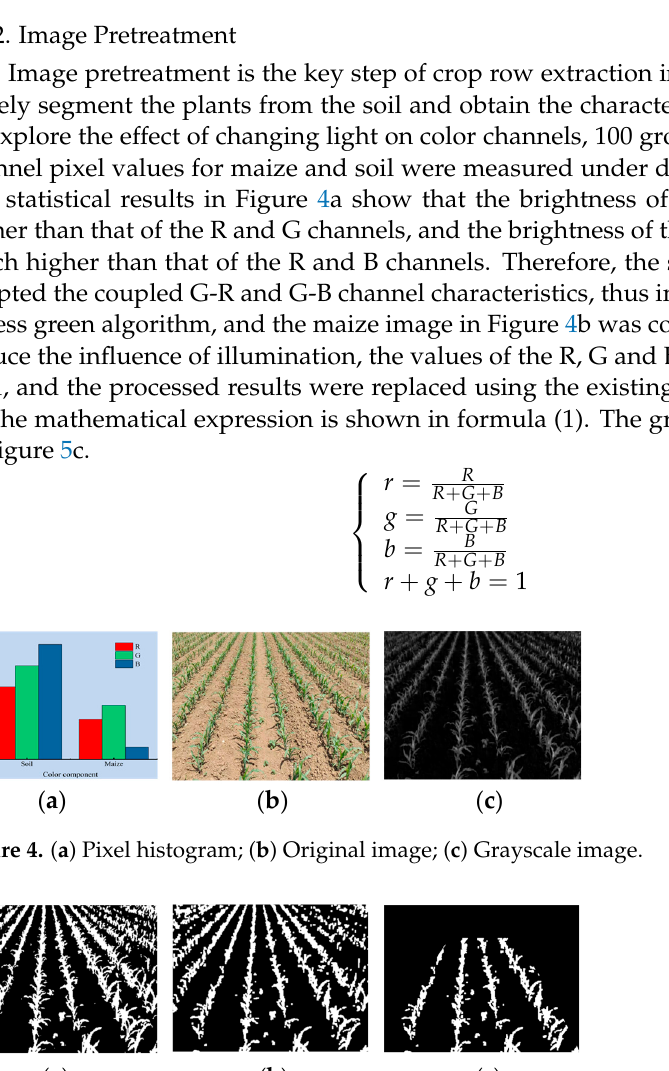
Figure 3. Guidance line extraction procedure for row-oriented spraying.